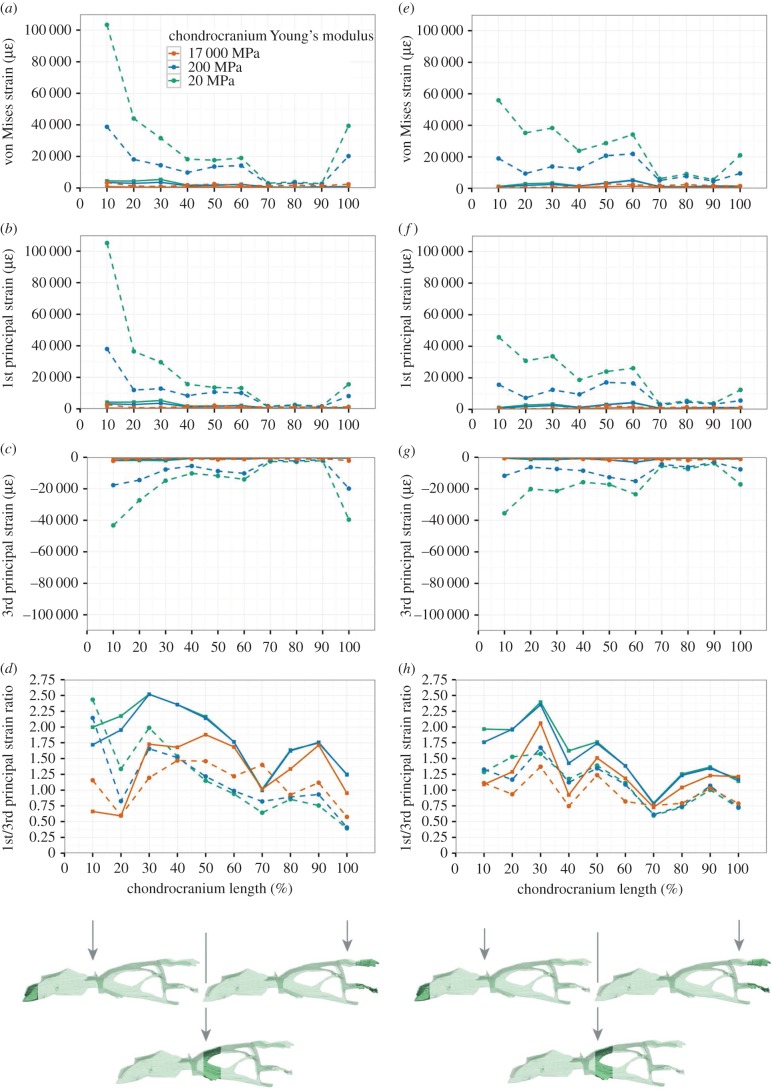
Strain plots within the chondrocranium during (a–d) anterior biting and (e–h) posterior unilateral biting. (a,e) von Mises strain, (b,f) 1st principal strain, (c,g) 3rd principal strain and (d,h) 1st/3rd principal strain ratio. Dashed lines represent models with patent sutures.